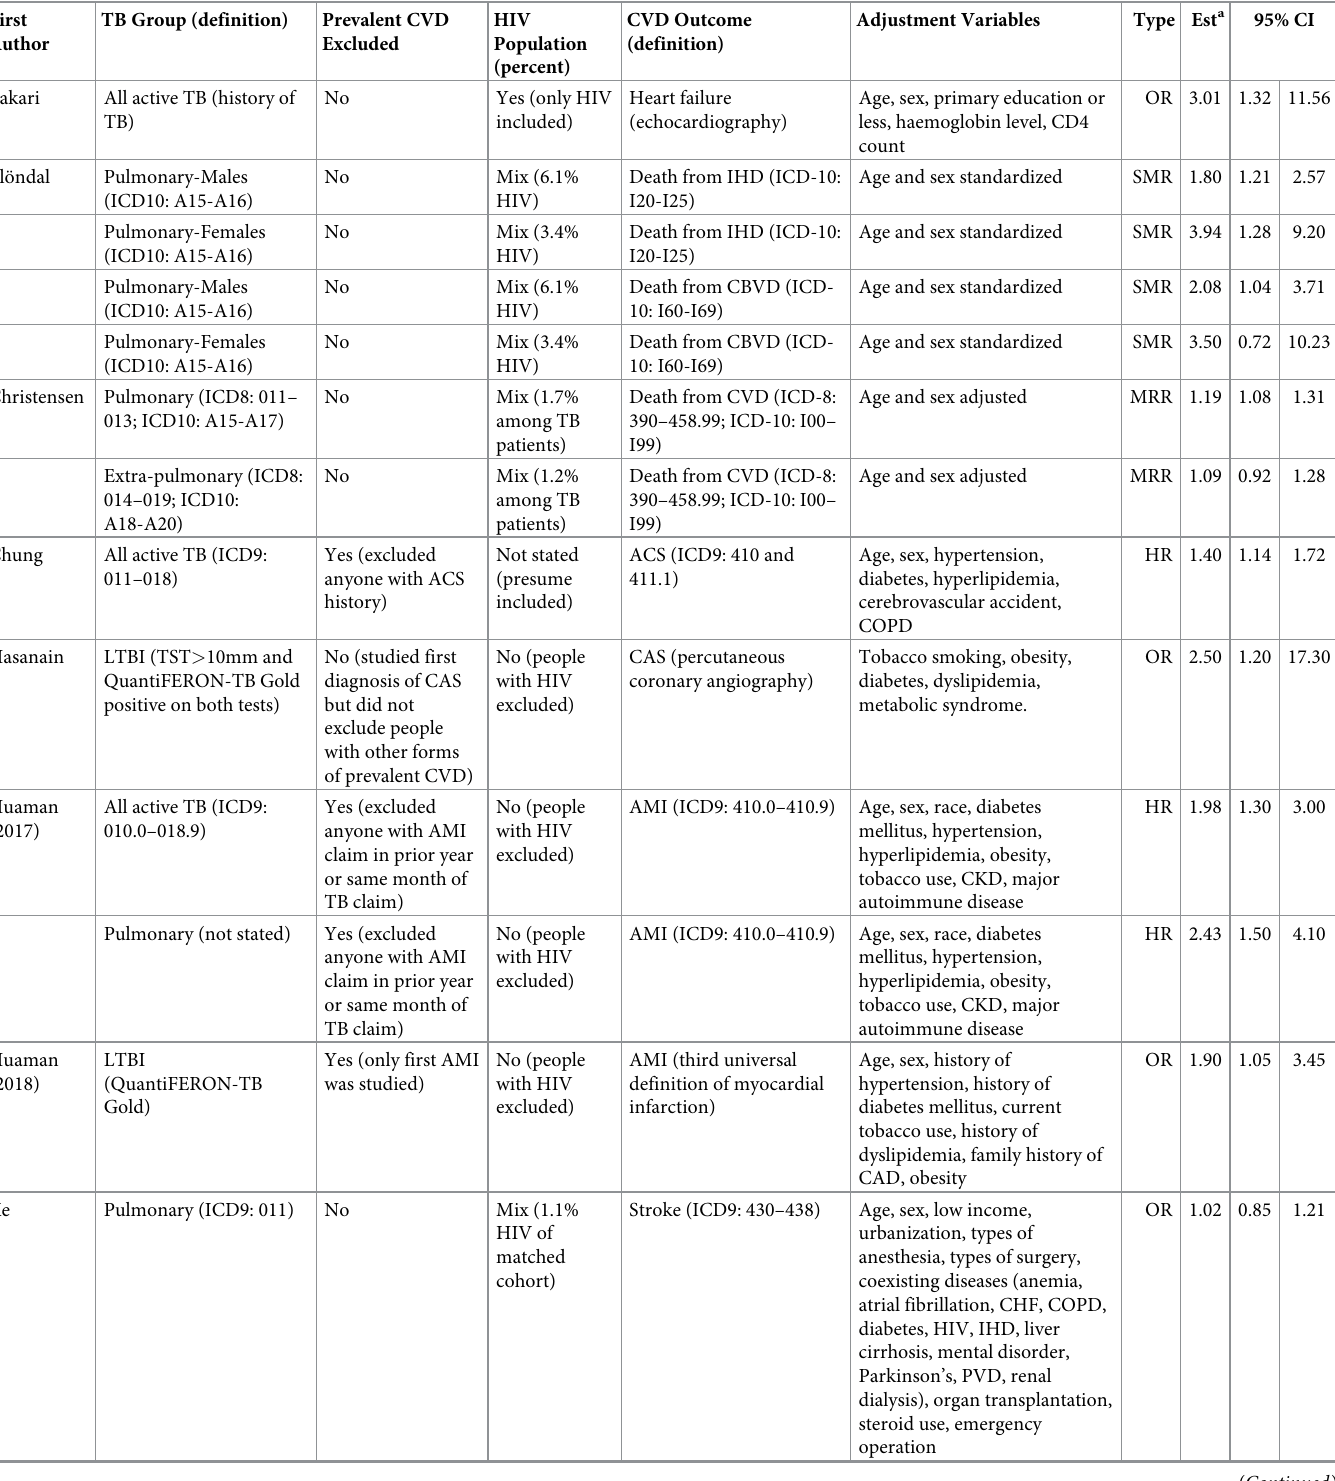
Table 2. Relative risk data extracted from included studies for systematic literature review of tuberculosis and risk of cardiovascular disease and related